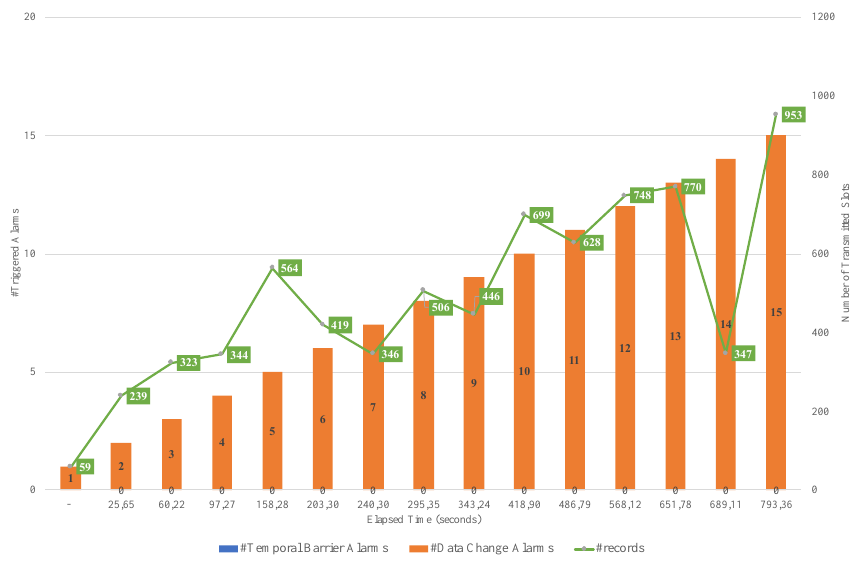
Figure 9. Evolution of the triggered alarms and data transmissions with the load-shedding technique and temporal barrier disabled (Simulation